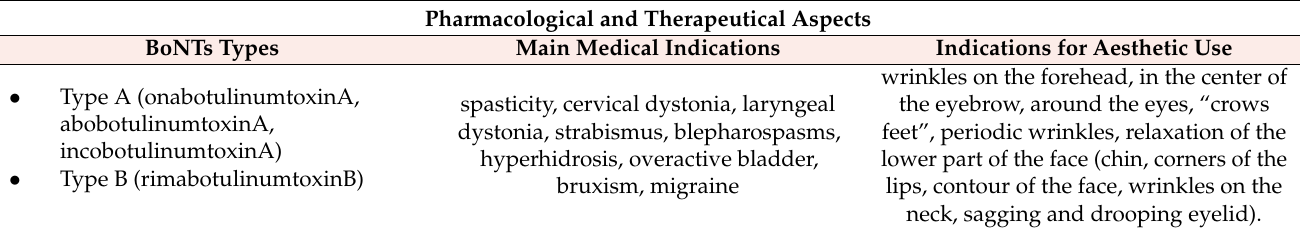
Table 4. The BoNTs types currently available: Botox ® (onabotulinumtoxinA), Dysport ® (abobotulinumtoxinA), and Xeomin ® (incobotulinumtoxinA) are the trade names for therapeutic use of botulinum toxin A. The FDA has approved the use of Botox ® for glabellar lines and “crow’s feet” and Dysport ® and Xeomin ® for glabella only, other uses are outside formal approval. Their dosage units are not equivalent, have different pharmacokinetics, and refer to different indications and uses. Less known is botulinum toxin type B (RimabotulinumtoxinB), also with medical applications, mainly in cervical dystonia, neck pain, and chronic sialorrhea, while there are five other serotypes C, D, E, F, and G. Pharmacological and Therapeutical Aspects BoNTs Types Main Medical